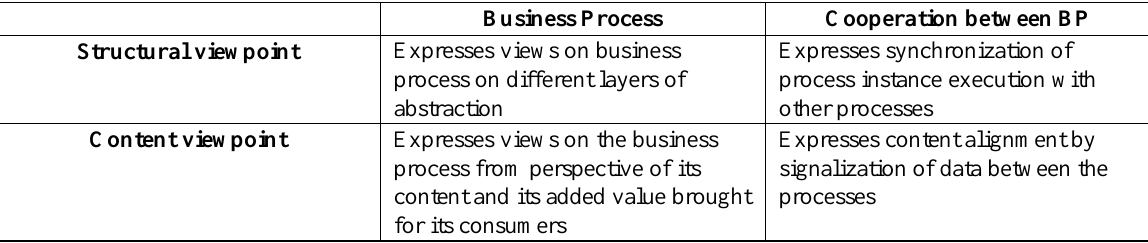
Table 4 . Structural and content viewpoint expressing unified process view of the